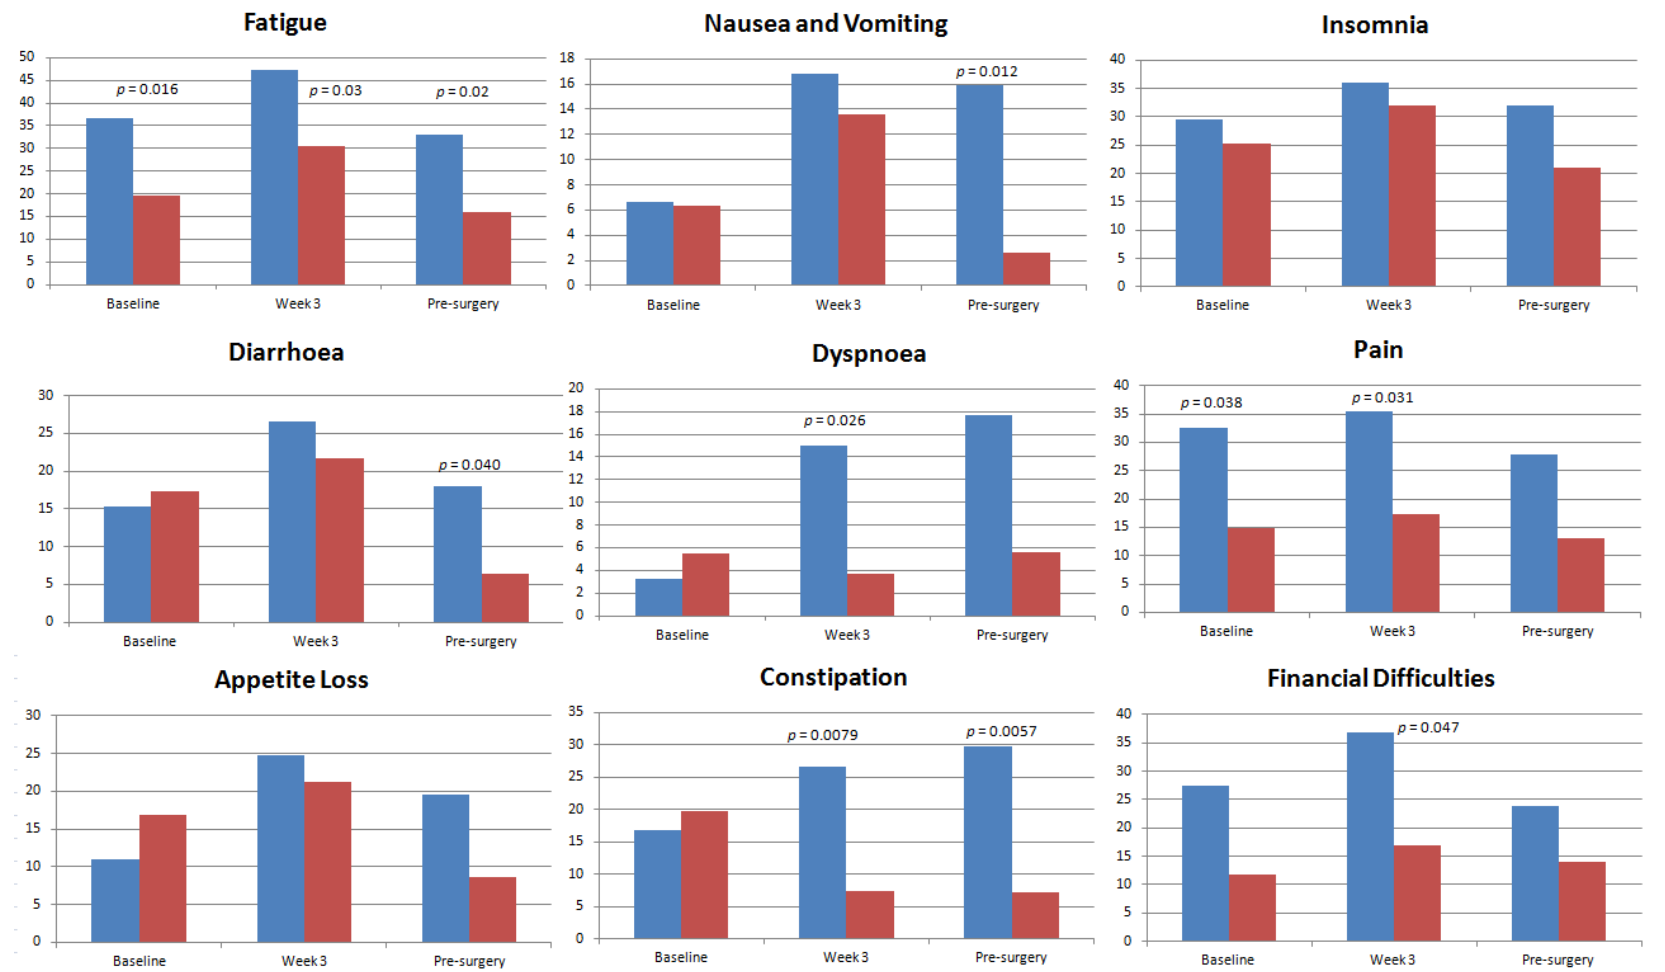
Figure 2. Health-related quality of life by ethnicity including functioning domains and symptom scales. Blue represents the Asian group; red represents the Caucasian group. The p -values are provided for significant differences between Asians and Caucasians at that time-point, based on pair-wise comparisons.